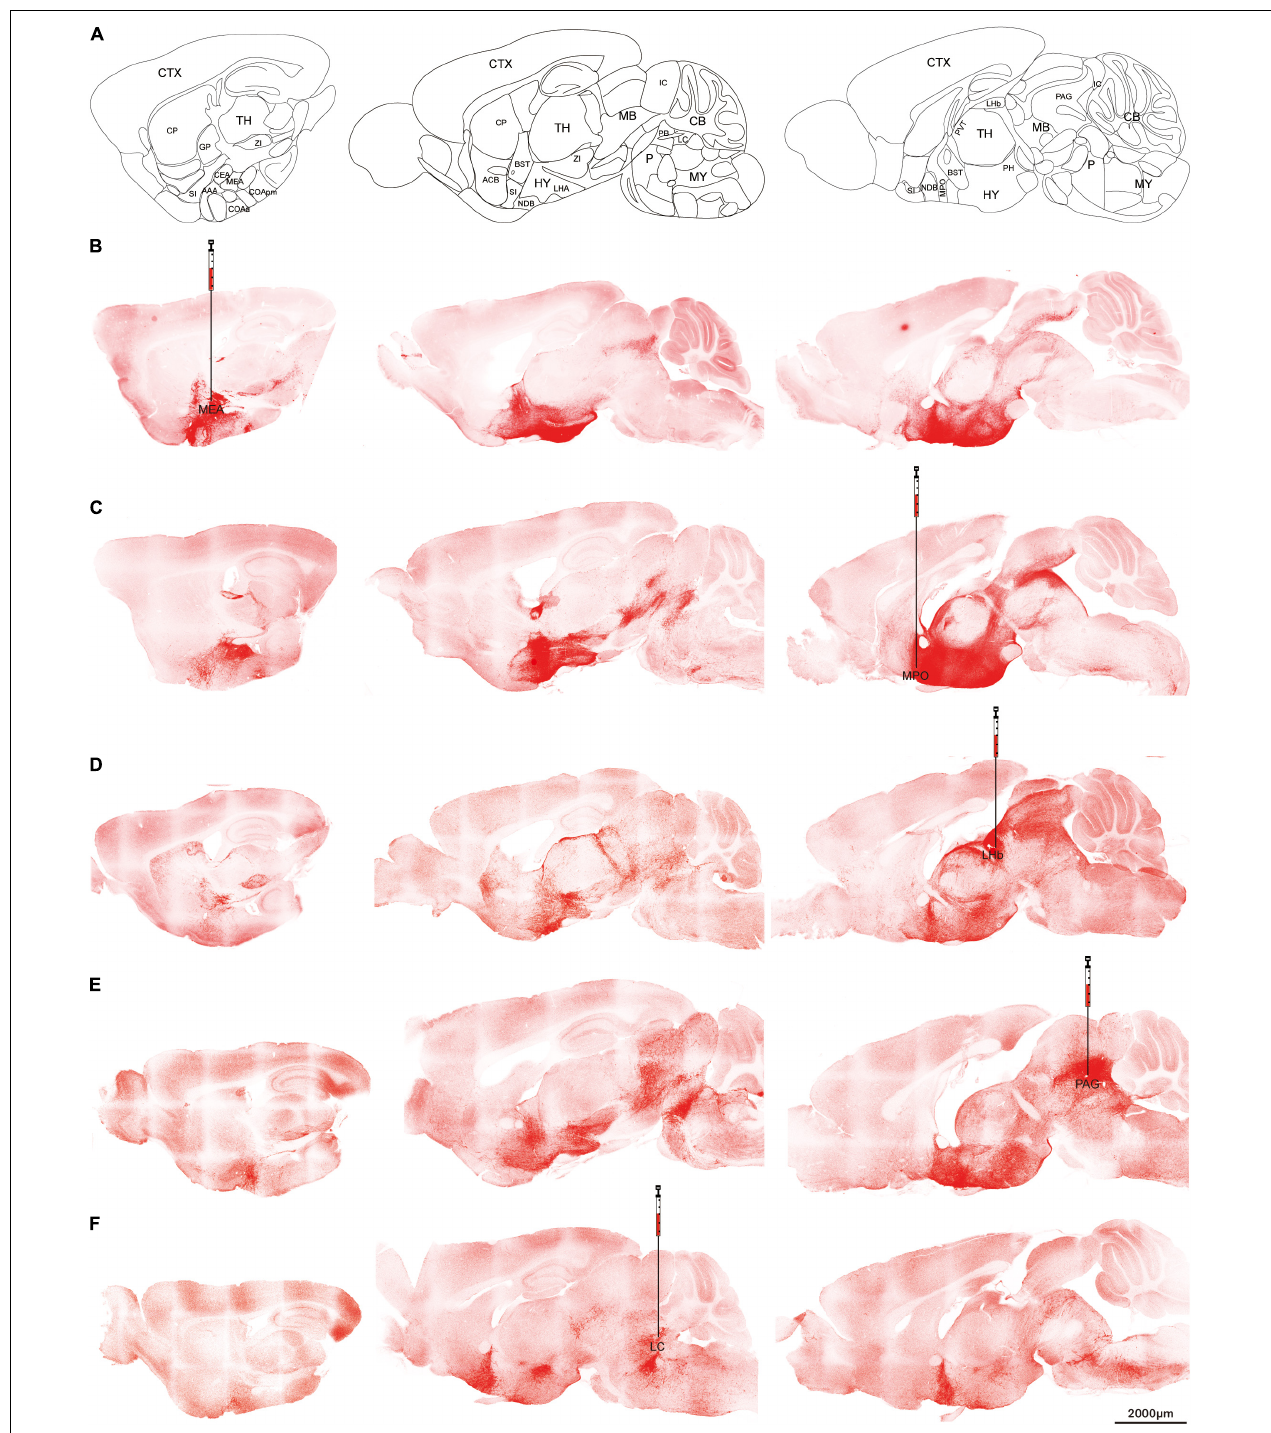
FIGURE 4 | Retrograde tracing Orexin fibers. Orexin-Cre mice received retrograde AAVretro-DIO-ChR2-mCherry injections at different target sites. (A) Sagittal atlas diagrams corresponding to the confocal images. (B–F) Five different injection sites including MEA (B) , MPO (C) , LHb (D) , PAG (E) , or LC (F) . Scale bars: 2,000 µ m. AAA, anterior amygdalar area; ACB, nucleus accumbens; BST, bed nuclei of the stria terminalis; CB, cerebellum; CEA, central amygdalar nucleus; COAa, cortical amygdalar area, anterior part; COApm, cortical amygdalar area, posterior part, medial zone; CP, caudoputamen; CTX, cerebral cortex; GP, globus pallidus; HY, hypothalamus; IC, inferior colliculus; LC, locus coeruleus; LHA, lateral hypothalamic area; LHb, lateral habenula; MB, midbrain; MEA, medial amygdalar nucleus; MPO, medial preoptic area; MY, medulla; NDB, diagonal band nucleus; P, pons; PAG, periaqueductal gray; PB, parabrachial nucleus; PH, posterior hypothalamic nucleus; PVT, paraventricular nucleus of the thalamus; TH, thalamus; SI, substantia innominata; ZI, zona incerta.